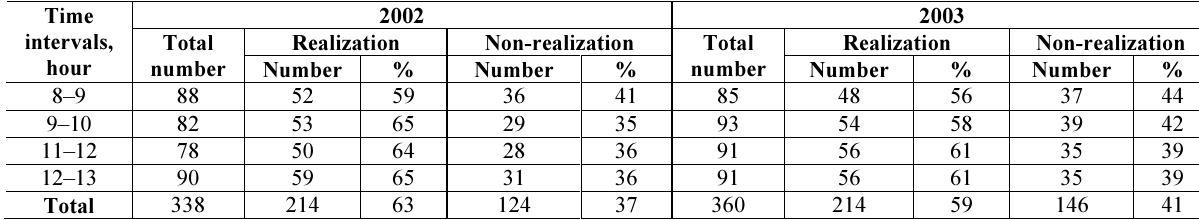
Table 2. Efficiency of prognostic connection of HCRF decrease between two adjacent days at an interval 1.2–1.6 MeV (criterion –15 imp/h) and atmospheric pressure (criterion 4 hPa) at various time intervals in Vilnius in 2002–2003